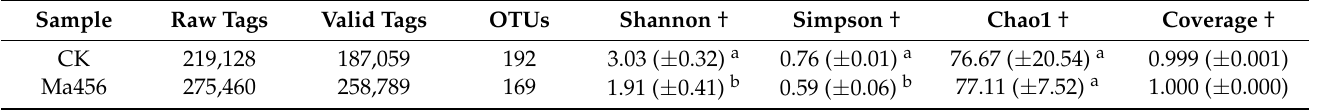
Table 1. Bacterial community alpha-diversity characteristics in the gut of BPH infected and unin- fected with fungal pathogen.